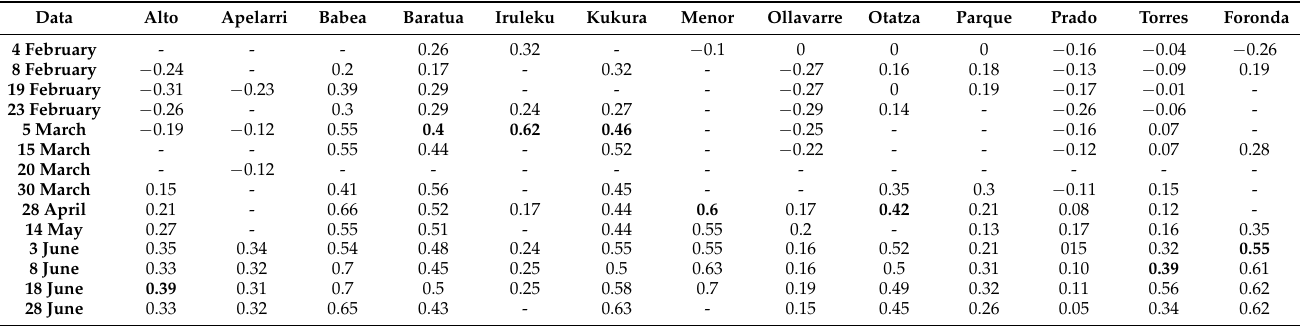
Table 4. Values of Kappa Index between yield map and NDVI images of different dates in 2019 for 13 wheat plots. In bold is the first date when a moderate agreement is